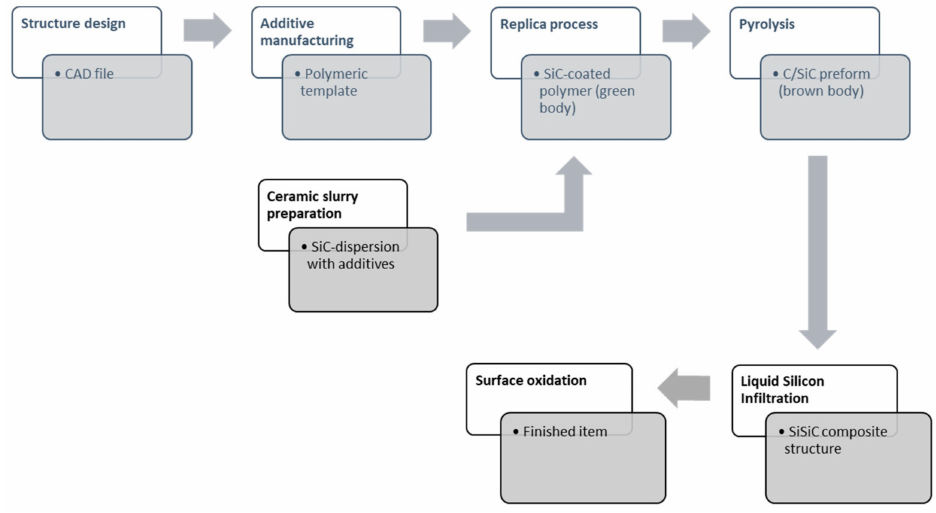
Figure 2. Process sketch for SiSiC lattices